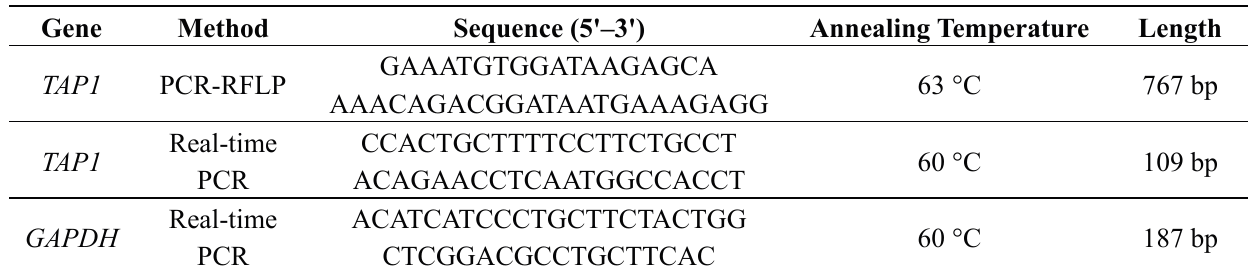
Table 4. Primer sequences and related